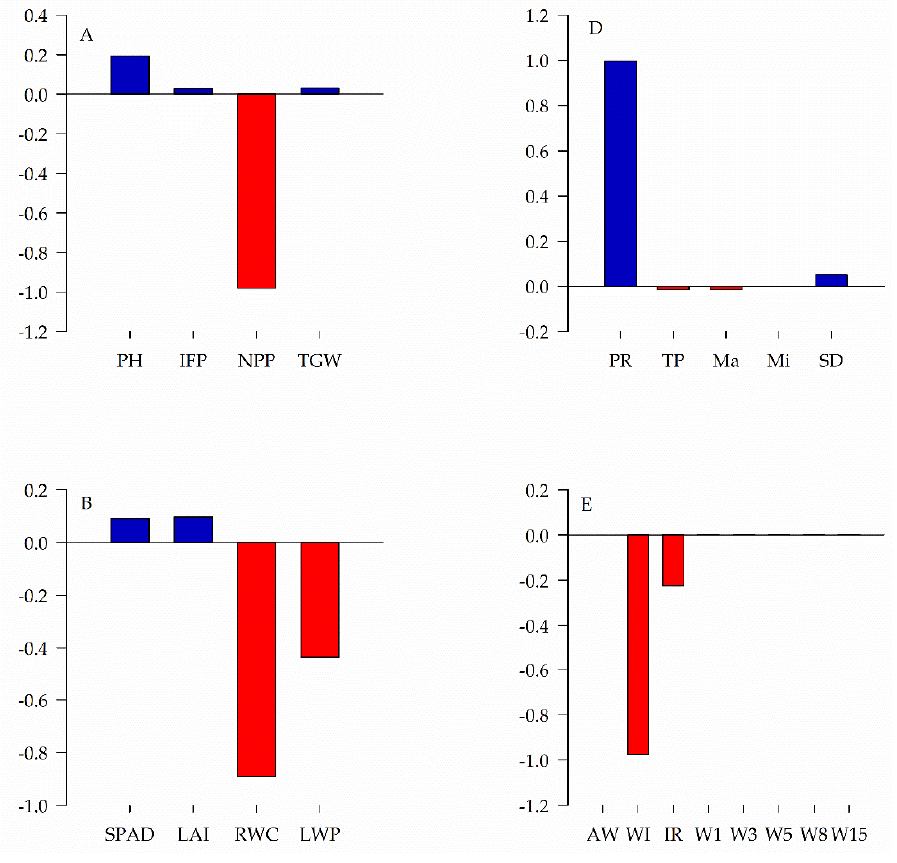
Figure 3. Loadings of variables in Yield components ( A ), Physiological traits ( B ), Root development ( C ), Soil physics ( D ), and Soil water ( E ). PH: plant height; IFP: insertion of first pod; NPP: number of pods per plant; TGW: thousand grain weight; SPAD: SPAD index; LAI: leaf area index; RWC: leaf relative water content; LWP: leaf water potential; RA: root area; ARD: average root diameter; RLD: root length density; RDM: root dry matter; PR: soil penetration resistance; TP: soil total porosity; Ma: soil macroporosity; Mi: soil microporosity; SD: soil density; AW: available water capacity; WI: accumulated water infiltration; IR: basic infiltration rate; W1: water stored 1 day after rain; W3: water stored 3 days after rain; W5: water stored 5 days after rain; W8: water stored 8 days after rain; W15: water stored 15 days after rain. By analyzing two-dimensional dispersion of treatments, it was observed that there was a difference between the soil management systems for all variables groups. Plants